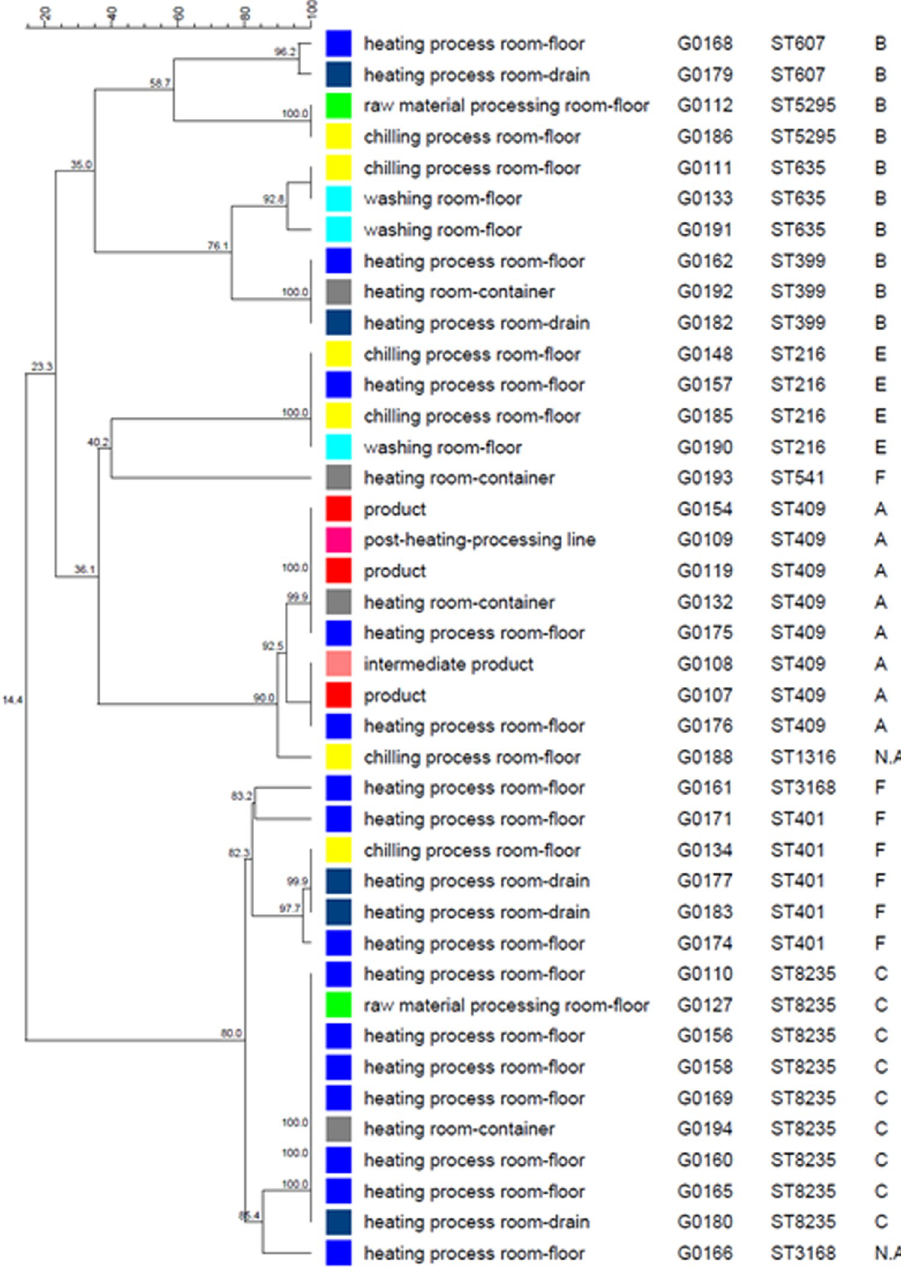
Fig 3. A phylogenetic tree constructed using the cgMLST profiles for 40 E . coli isolates from a food manufacturing plant. cgMLST profiles were generated using the 2513 core genes. The trees were constructed using the UPGMA algorithm. For comparison, the results of classical MLST and ribotyping patterns are also